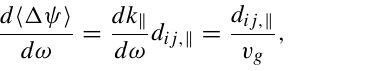
indeed thin in the meaning that the width is comparable to electron